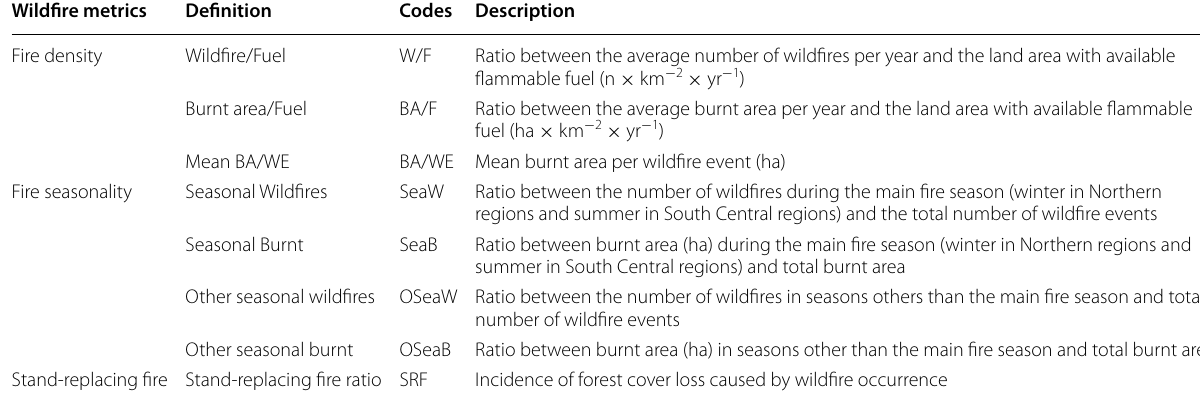
Main fire season the X months with the highest burnt area (winter in Northern regions and summer in South Central regions); Land area with available flammable = fuel all the codes of the Corine Land Cover 2012 belonging to class 3 (except for 335 and 332) and 243 and 244 (Land principally occupied by agriculture with = significant areas of natural vegetation and agro-forestry areas, respectively)